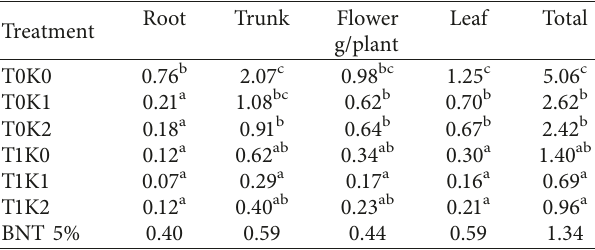
Table 3: Dry weight of